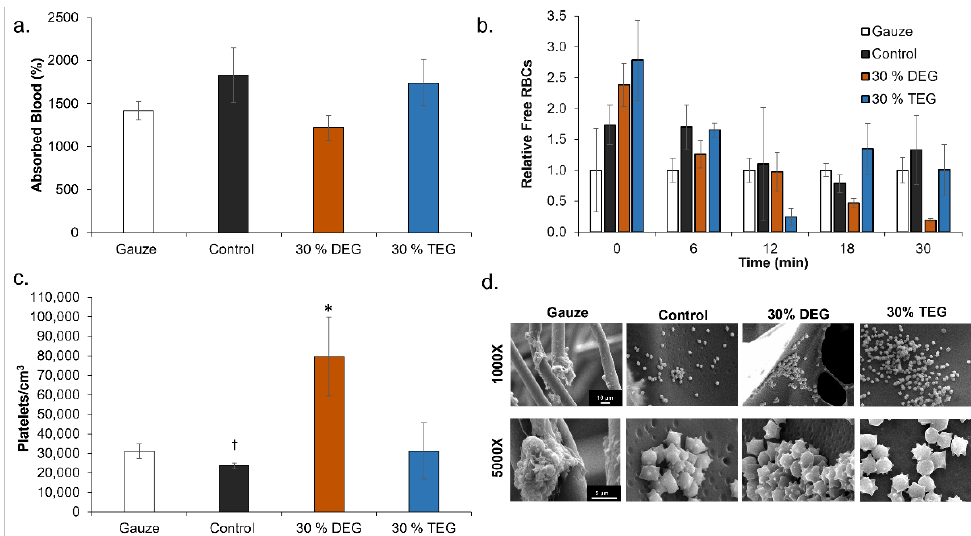
Figure 8. Cell and blood interactions with SMP foams. ( a ) Whole porcine blood absorption after 24 h of incubation (n = 3). ( b ) Average blood coagulation profiles represented free RBCs relative to clinical control (gauze) over 30 min (n = 4). * p <0.05 relative to gauze. ( c ) Platelet attachment to sample surfaces (n = 3, * p < 0.05 relative to all samples, † p < 0.05 relative to gauze). Mean ± standard deviation displayed in all panels. ( d ) SEM micrographs of attached platelets. Scale bars are shown in Gauze column apply to all other images in each row.